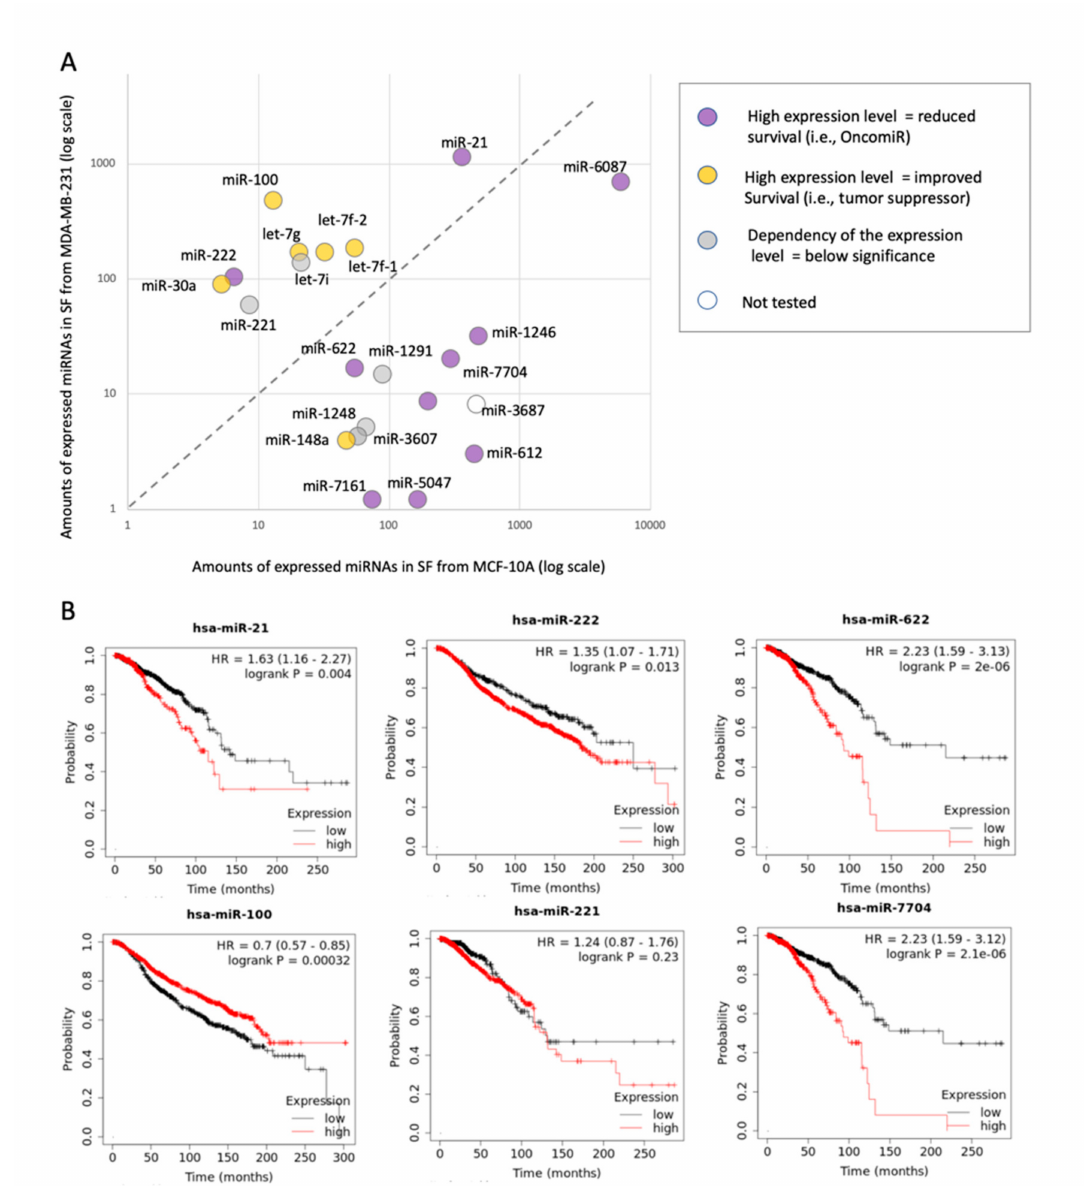
Figure 9. Expression of SF-miRNAs in di ff erent cell-lines vis- à -vis the patient’s overall survival rate. ( A ) Scatter plot of the SF-miRNAs expression in non-cancerous MCF-10A cells (x-axis) and metastatic MDA-MB-231 cells (y-axis) is presented. A total of 22 di ff erentially expressed SF-miRNAs are listed with a minimal expression levels of > 50 reads (sum of MCF-10A and MDA-MB-231 expression reads). The results of the Kaplan–Meier (KM) survival plots are color coded with miRNAs that are oncogenic (purple), protective (yellow), and statistically insignificant (grey). Each tested miRNA is colored by the survival rate from breast cancer patients extracted from the TCGA (1062 samples) and METABRIC (1262 samples) projects. The KM survival plots analyze the survival (in months) associated with high and low expression quartiles of the selected miRNAs. Analysis is completed for 21 of the 22 SF-miRNAs (see Supplemental Table S6). ( B ) Representative SF-miRNAs analyzed by KM survival plots with respect to the calculated hazard ratio (HR, 95% confidence intervals) and logrank with a p -value <